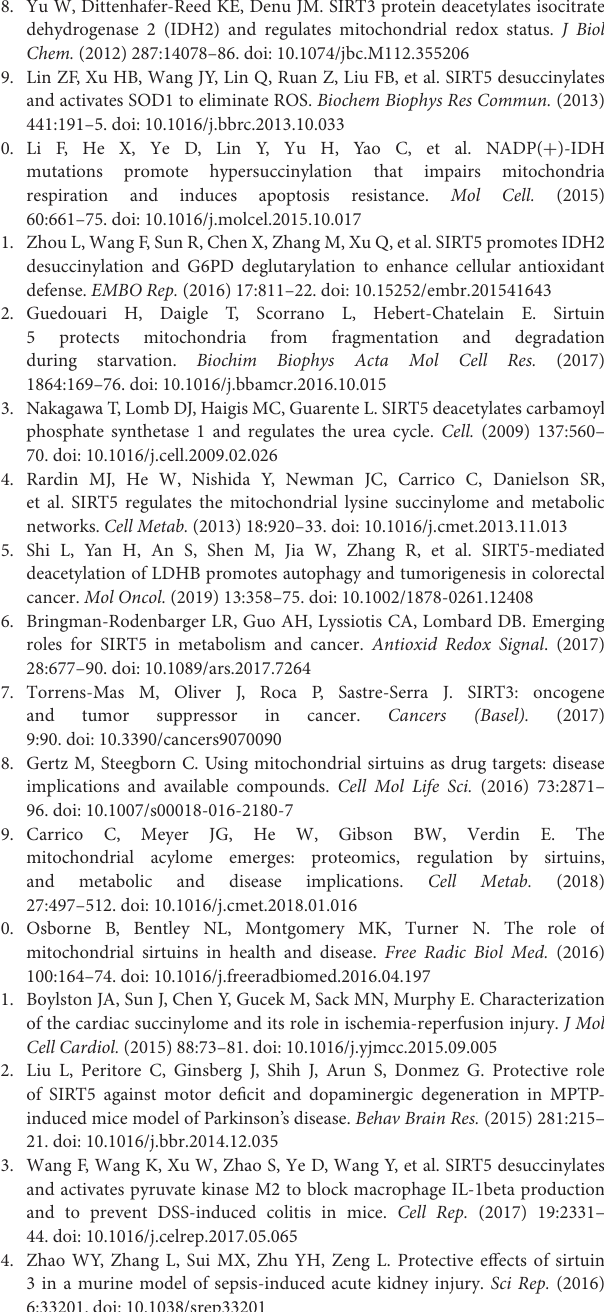
Supplementary Figure S2 | Gating strategies for flow cytometry analysis. CD117 encodes for c-kit. Supplementary Figure S3 | (A) Extracellular acidification rate (ECAR) by SIRT3/5 + / + and SIRT3/5 − / − BMDMs exposed to LPS (10ng/ml) measured using the Seahorse technology. (B) Oxygen consumption rate (OCR) and ECAR by SIRT3/5 + / + and SIRT3 − / − BMDMs measured using the Seahorse technology. Data are means ± SD from three mice aged 10–12 weeks analyzed in